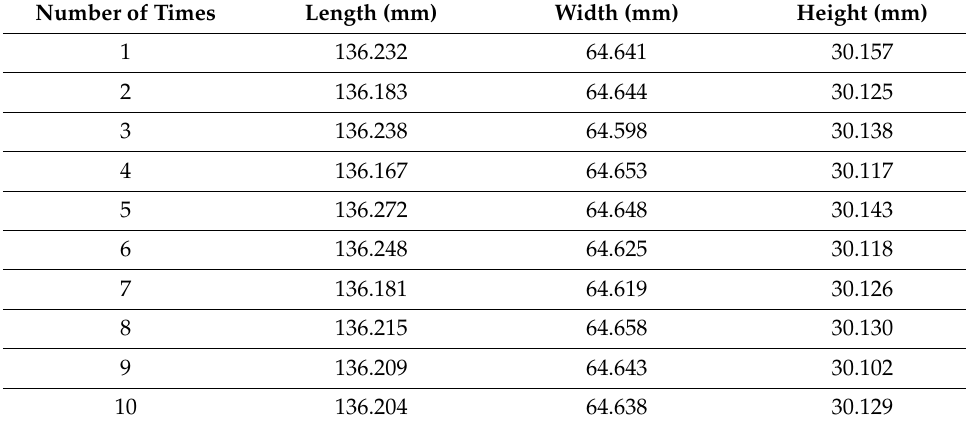
Table 3. Measured size of the gearbox